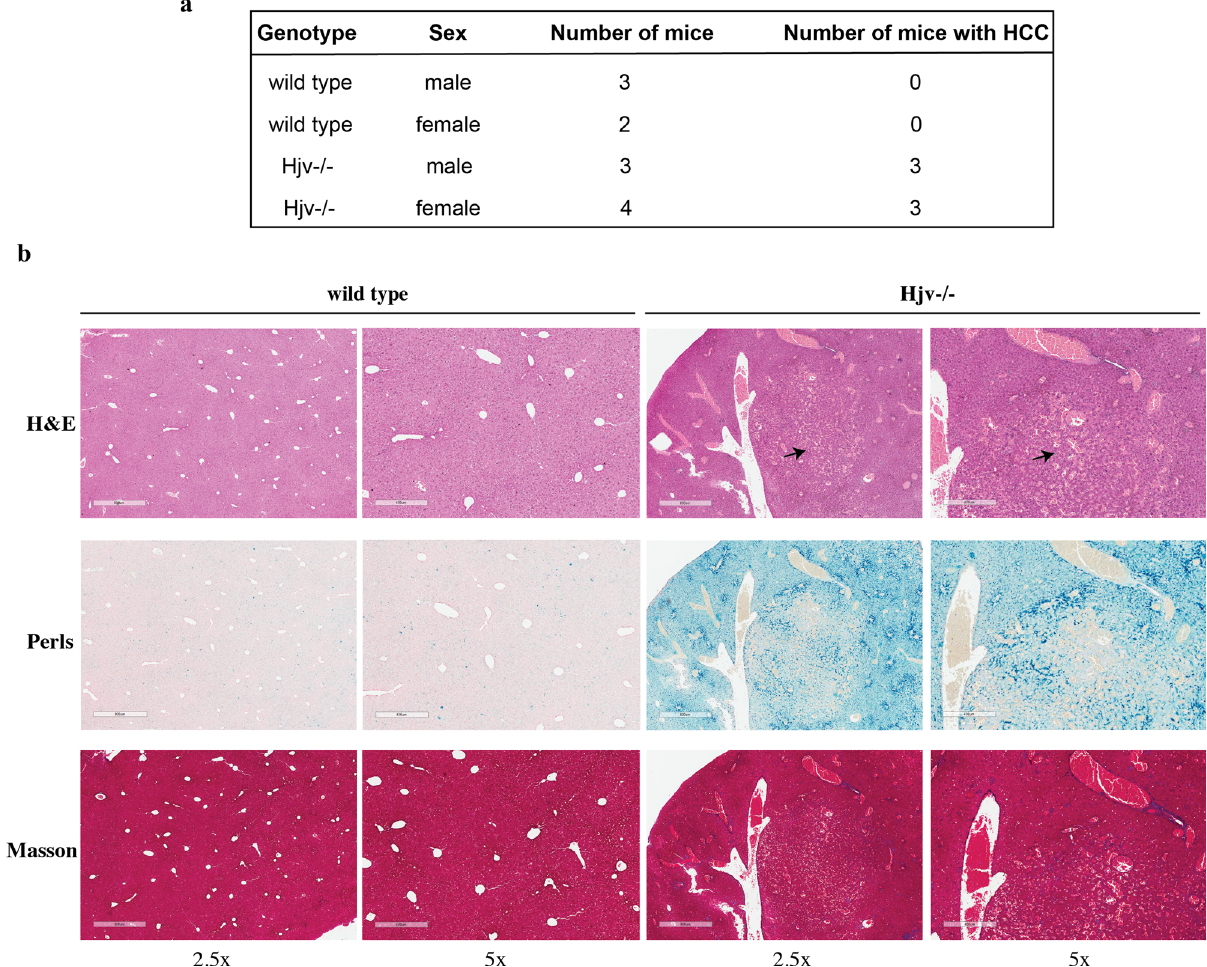
Fig. 4 Histopathological analysis of livers from aged wild type and Hjv − / − mice. a Genotypes, sex, numbers of mice and numbers of mice with histologically documented HCC. b Representative liver sections stained with H&E, Perls or Masson ’ s trichrome (magni fi cations: 2.5× and 5×). HCC lesions are indicated by